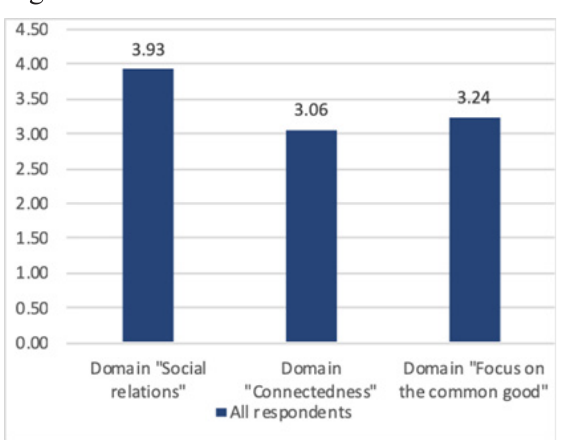
Figure 1. Results of social cohesion